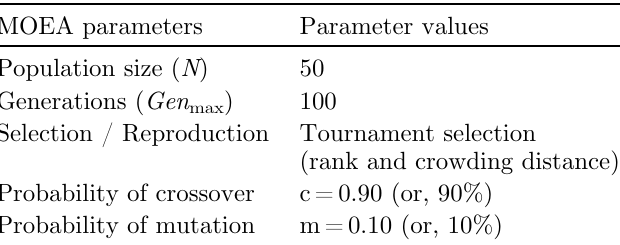
Table 4. NSGA-II input control